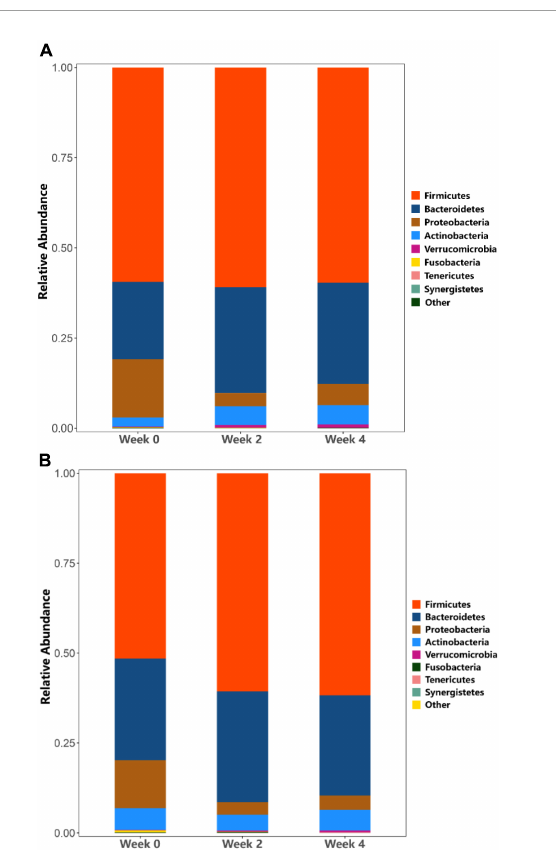
Analysis of phylum taxa abundance. (A) Phylum taxa abundance in the probiotic (treatment) group. (B) Phylum taxa abundance in the placebo (control)